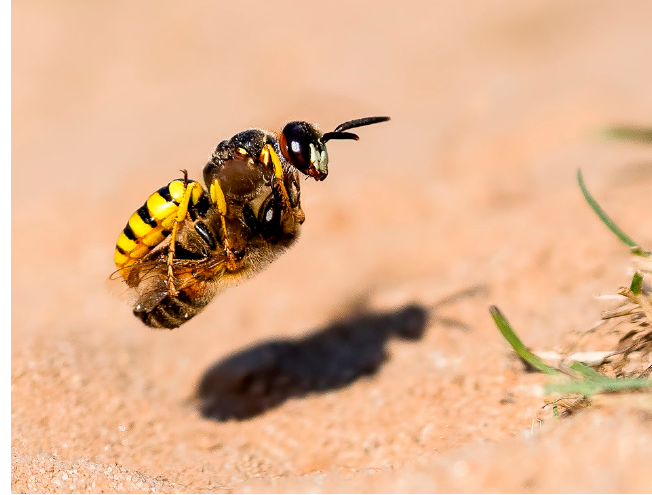
Figure 11. Beewolf with honey bee prey. Courtesy of Simon Jenkins http://www.simon-jenkins.photography.